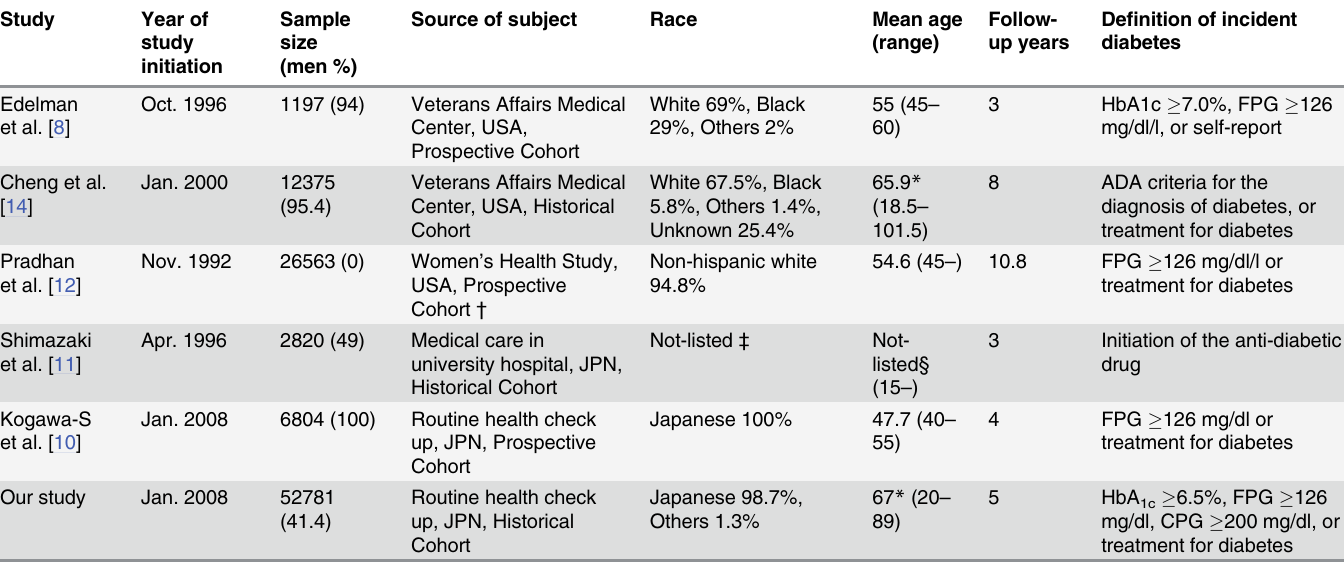
Table 4. Characteristics of the studies which evaluated the incidence of type 2 diabetes using baseline HbA 1c